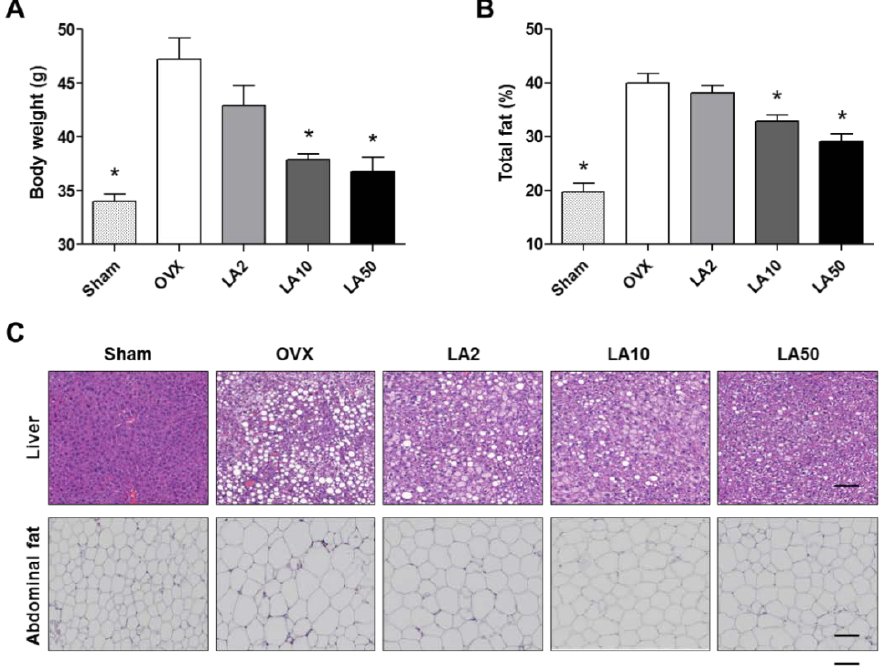
Figure 4. Anti-obesity effects of loganic acid in ovariectomy (OVX)-induced obesity mice. ( A, B ) After 12 weeks of feeding, the total body weight and total fat percentage of the mice was measured in the sham-operated mice (Sham), the ovariectomized mice (OVX), and the OVX mice with oral administration of loganic acid (LA2, LA 10, and LA 50: 2, 10, and 50 mg/kg/day, respectively). The body weight and total fat of all of the mice were measured using an electronic scale and PIXImus small animal densitometer, respectively*: p < 0.05 vs. OVX mouse group (Tukey’s HSD post hoc test, ANOVA); ( C ) Hematoxylin and eosin (H&E)-stained images of liver and abdominal visceral fat tissues.